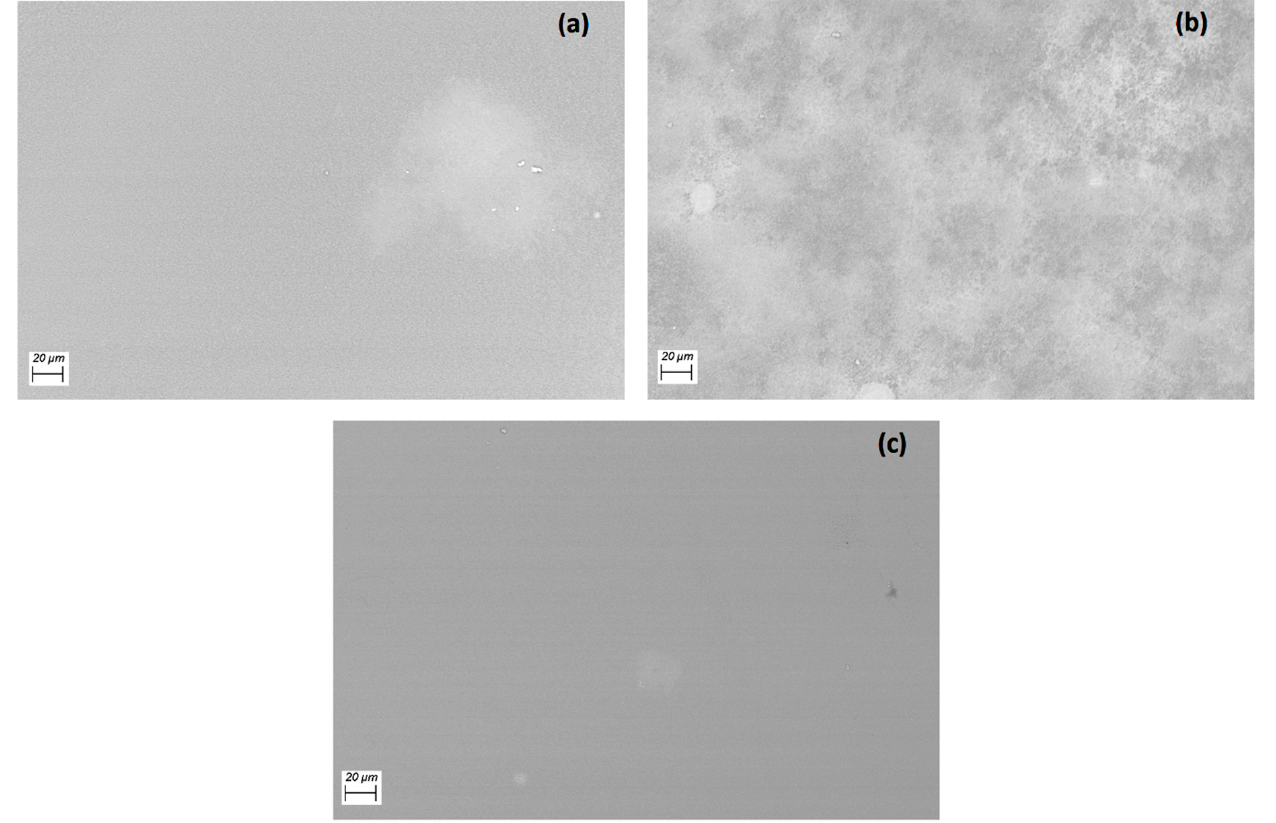
Figure 2. SEM images of ( a ) MoO 3 /PEDOT:PSS-A organotin (IV), ( b ) MoO 3 /PEDOT:PSS-B organotin (IV) and ( c ) MoO 3 /PEDOT:PSS-C organotin (IV) films.